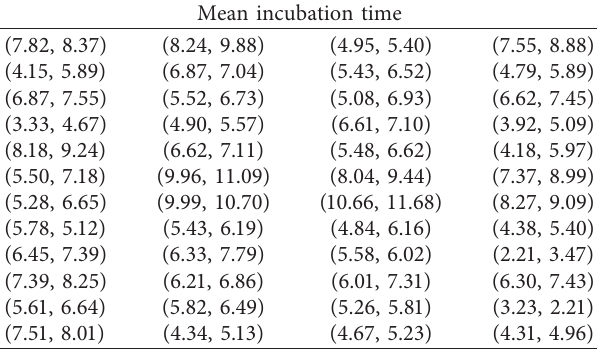
Table 3: Mean incubation periods with uncertainties for COVID- 19.